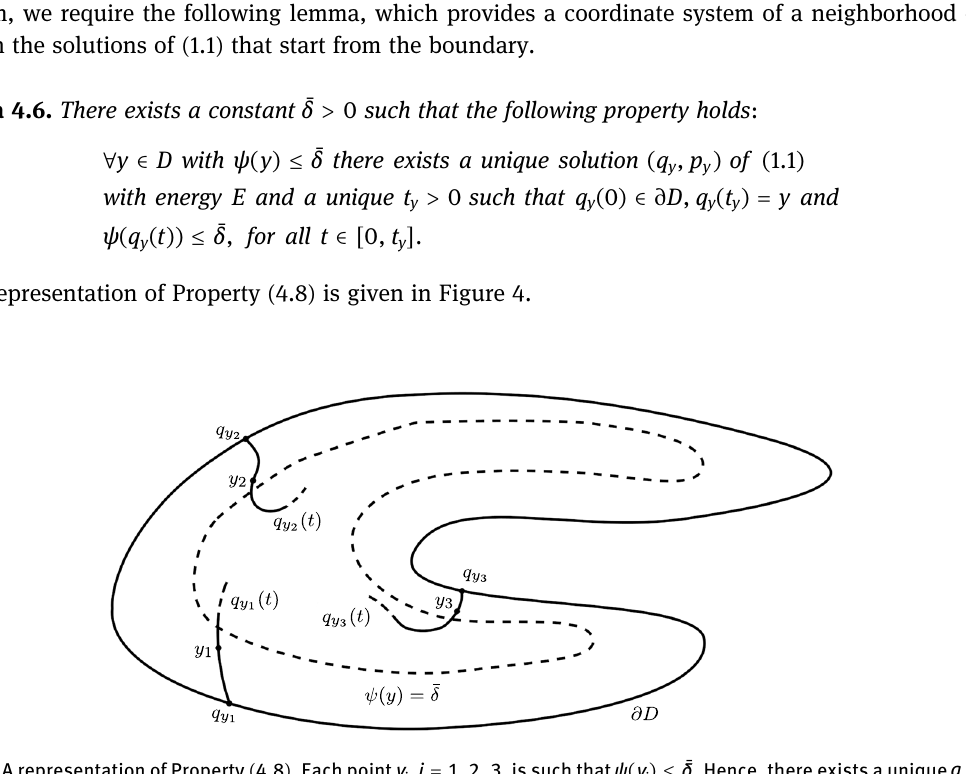
Figure 4: A representation of Property ( 4.8 ) . Each point y